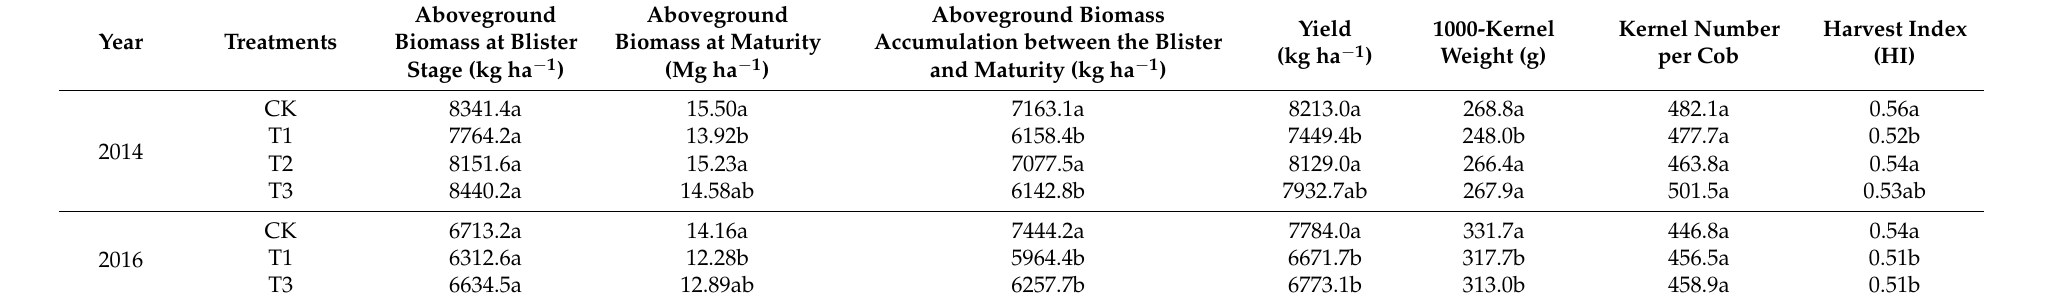
Table 2. Aboveground biomass, grain yield, yield components, and harvest index in 2014 and 2016